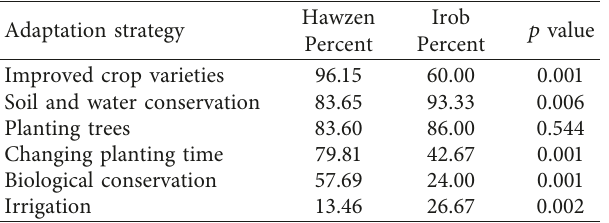
Table 7: Adaptation strategies to perceived temperature and rainfall changes ( n �